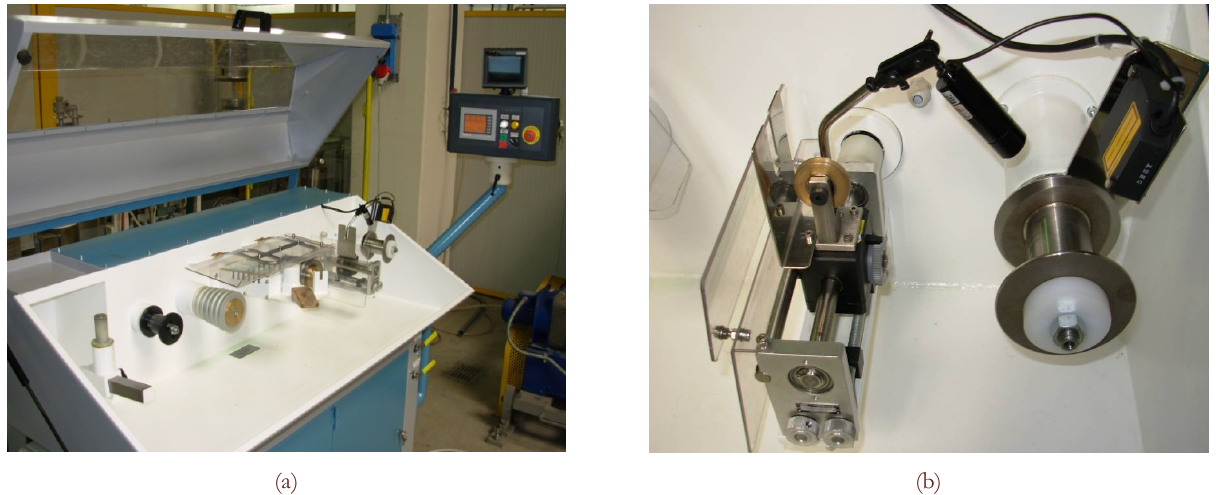
Figure 1: a) Experimental drawing system b) laser sensor-controlled spooling system for correct distribution of the wire on the spool and camera for checking correct wire pay-on